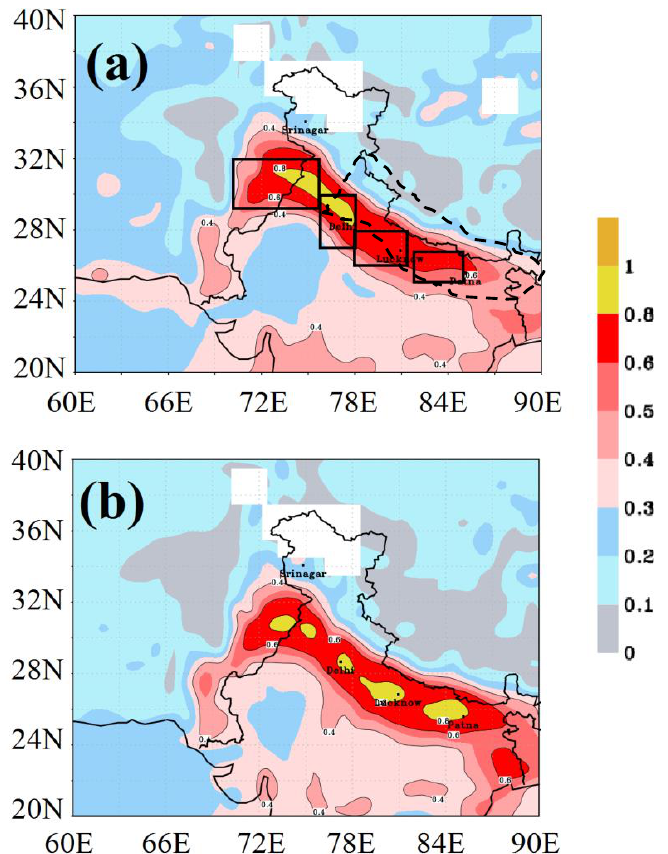
Figure 1. AOD climatology 2002 – 2019 from MODIS-Aqua ( a ) October, Boxes here: Northwestern region (70° E – 76° E, 29° N – 32° N), Delhi region (76° E – 78° E, 27° N – 31° N), Lucknow region (78° E – 81.5° E, 26° N – 28° N), and Patna region (82° E – 85° E, 25° N – 27° N). The dashed line in black marks the boundary of the IGP region. ( b ) November months over the Indian region (60° E – 90° E, 20° N – 40° N).